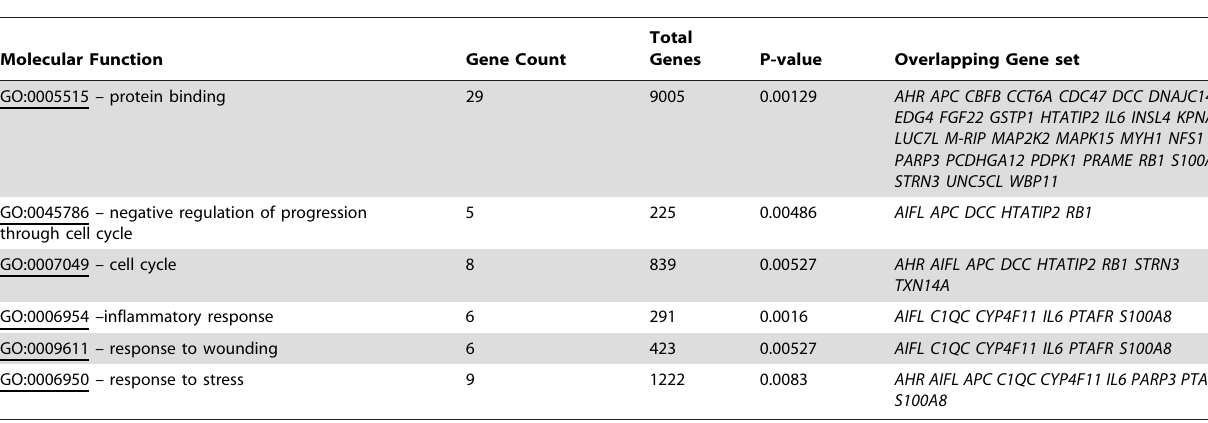
Table 4. Gene ontology analysis, genes with differential methylation.